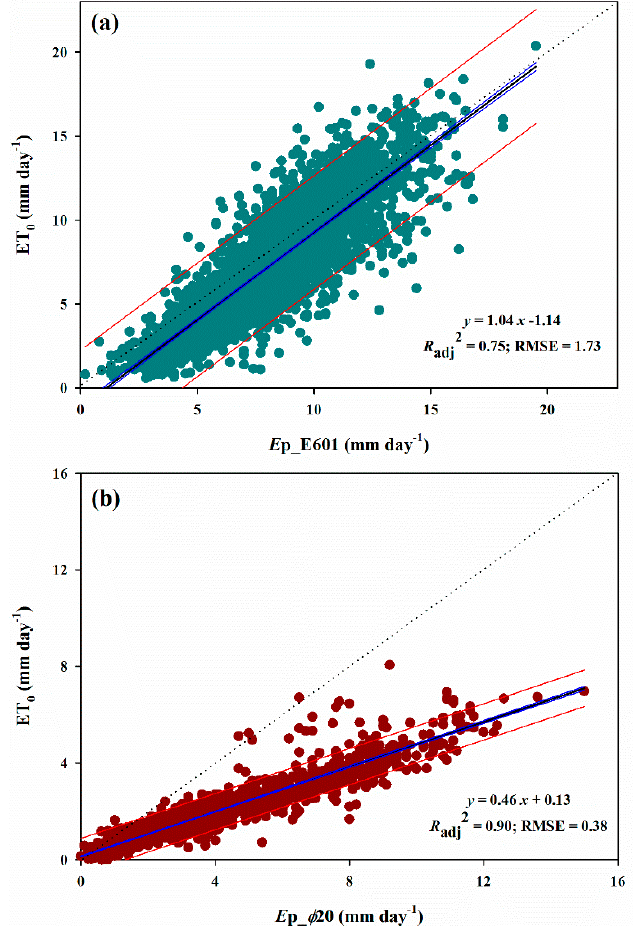
Figure 5. Relationship between daily pan evaporation of ( a ) E601 ( E p_E601 ) and ( b ) φ 20 ( E p_ φ 20 ) and calculated reference crop evapotranspiration (ET 0 ) by the FAO Penman–Monteith equation for the Ejin station during the unfrozen period from 1986 to 2001. The linear fitting, 95% confidence band, prediction band line, and value of regression analysis are shown.